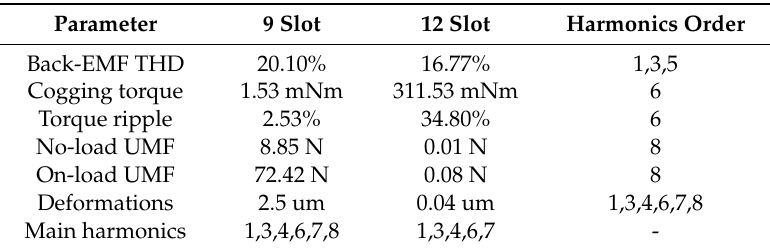
Figure 8. NVH characteristic analysis results of permanent magnet machines with two different pole/slot combinations: ( a ) 8-pole 12-slot and ( b ) 8-pole 9-slot. Table 1. The comparison of results of PMSMs according to slot.